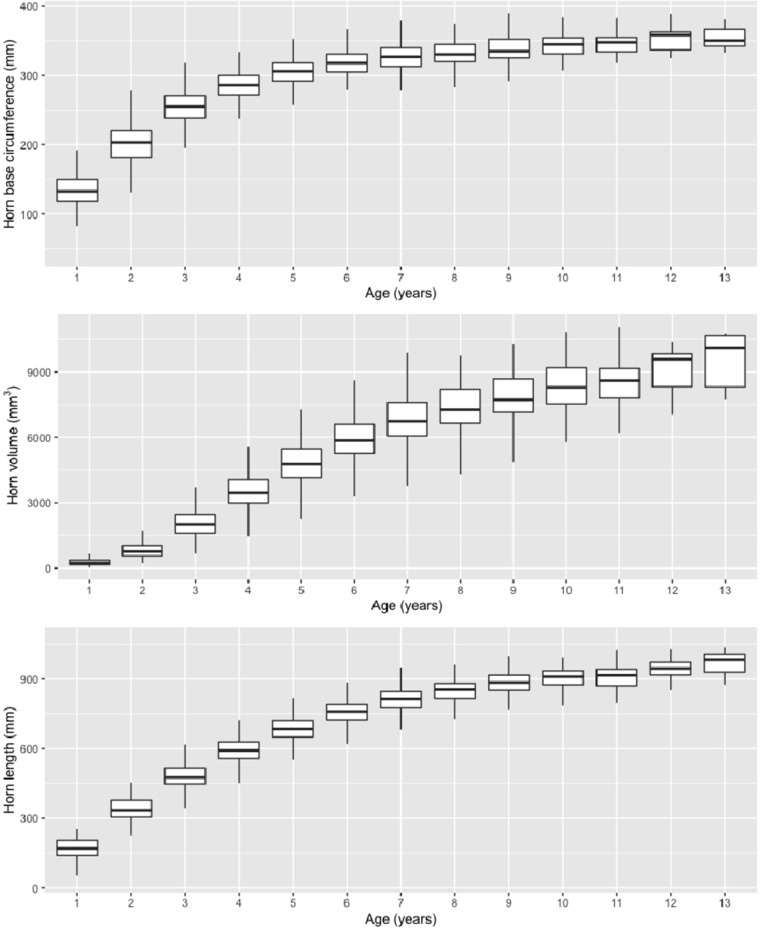
Plots of horn size traits as function of age class.